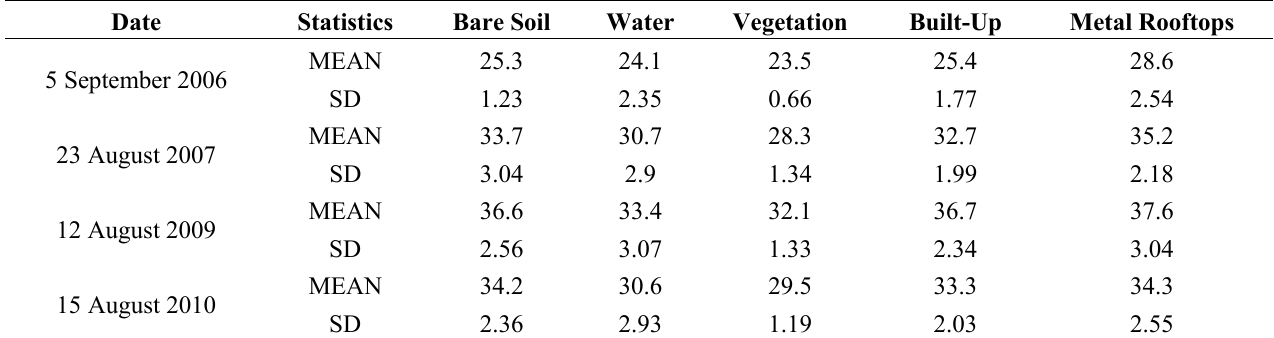
Table 5. Descriptive statistics of LST (in °C) derived from Landsat TM images over different land cover types.